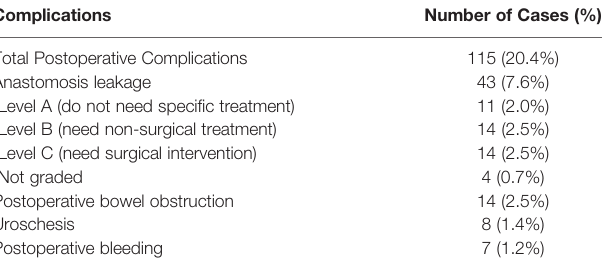
TABLE 2 | Postoperative complications of 563 cases after LA-taTME.